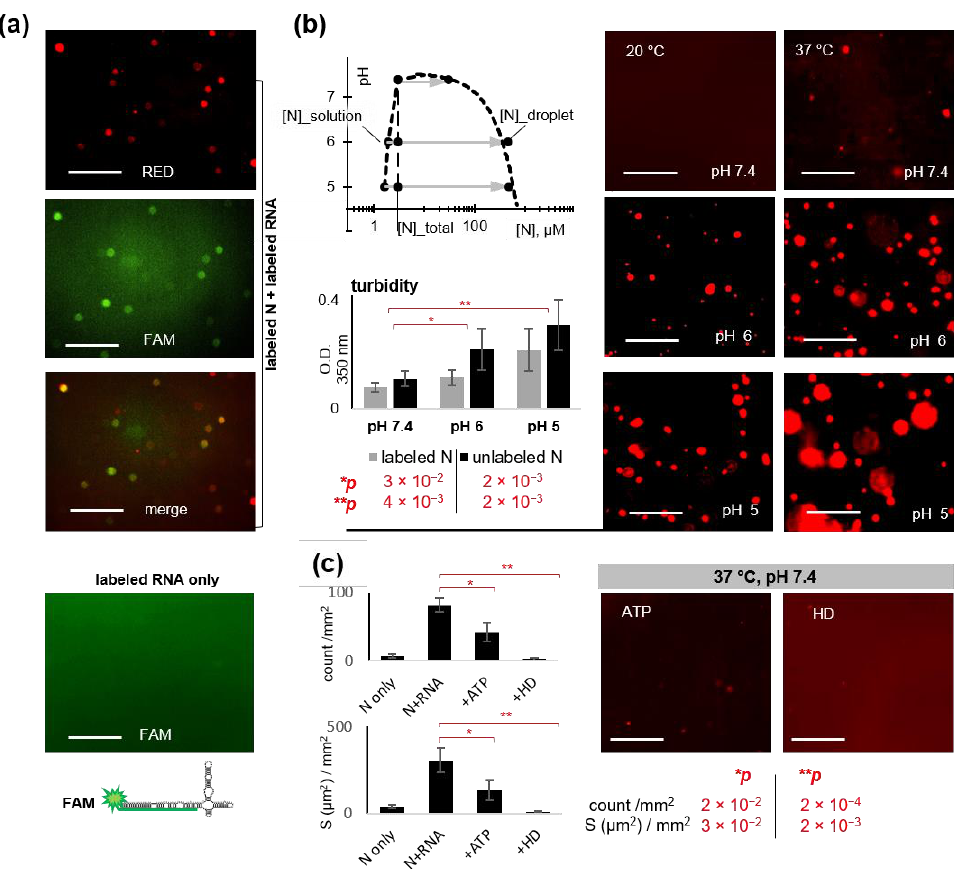
Figure 3. Condition-dependence of the N-RNA condensates and their sensitivity to known LLPS modulators. ( a ) Verification of N colocalization with RNA. Representative fluorescence microscopy images of the mixtures of RED-labeled N (3 µ M) and FAM-labeled tr-SL5_long/SL5-tag (6 µ M) after overnight incubation in 20 mM Tris-HCl, pH 7.4, at 37 ◦ C. ( b ) Temperature and pH-dependence of the N-RNA condensates (3 µM N and 6 µM SL5_long). Left top panel: schematic phase diagram summarizing the microscopy-based analysis of droplet formation in the labeled N-RNA mixtures after 2 h of incubation in 20 mM Tris-HCl, pH 7.4, or 20-mM sodium-acetate, pH 5 – 6, at 37 °C. Left bottom diagram: summary of the turbidity assays with the labeled and unlabeled N-RNA mixtures under the same conditions. Right panel: representative fluorescence microscopy images of the labeled N-RNA mixtures after 2 h of incubation at pH 5 – 7.4 at 20 °C and 37 °C. ( c ) Sensitivity of the N-RNA condensates (3 µM N and 6 µM SL5_long) to known LLPS modulators ATP and 1,6-hexanediol (HD) at 37 °C. Scale bars: 10 µm.